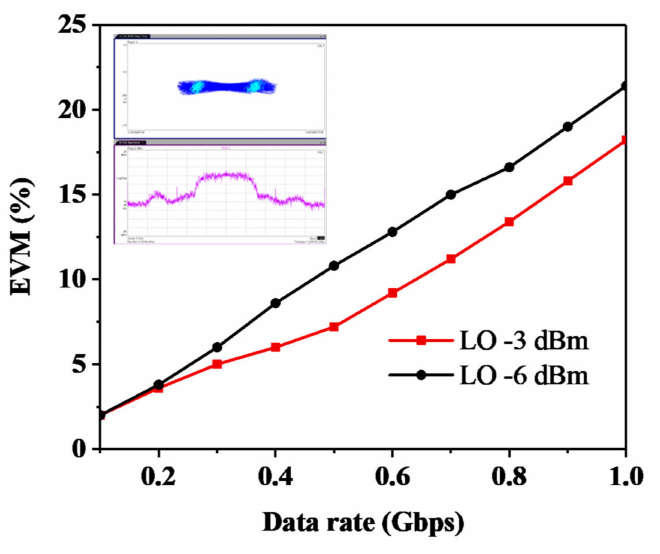
Figure 6. The measured error vector magnitude (EVM) performance of